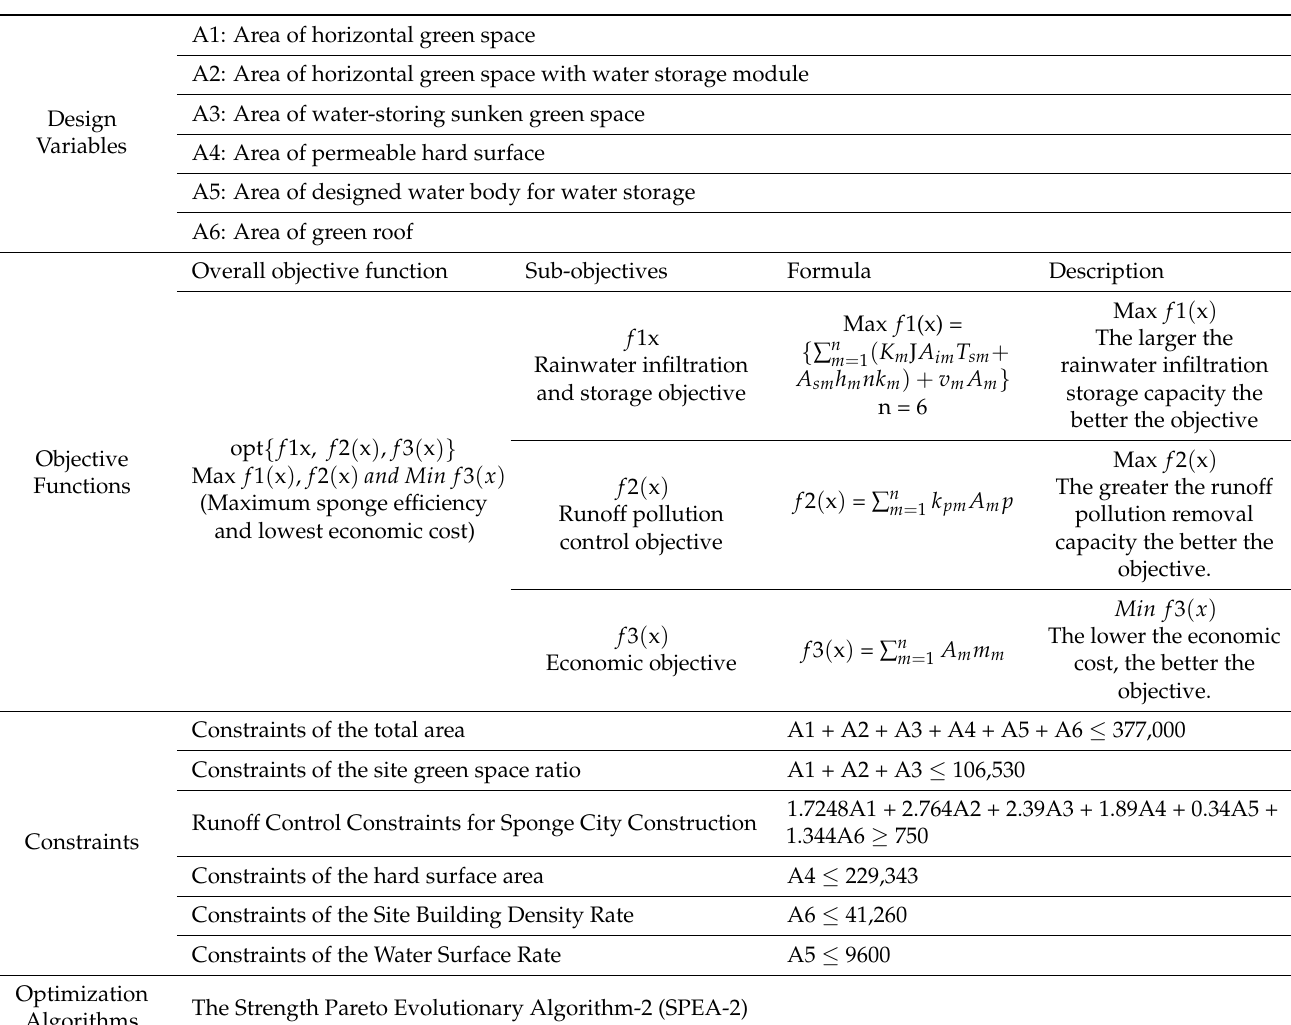
Table 6. A list of elements for a multi-objective combined optimization model for sponge facilities in the study